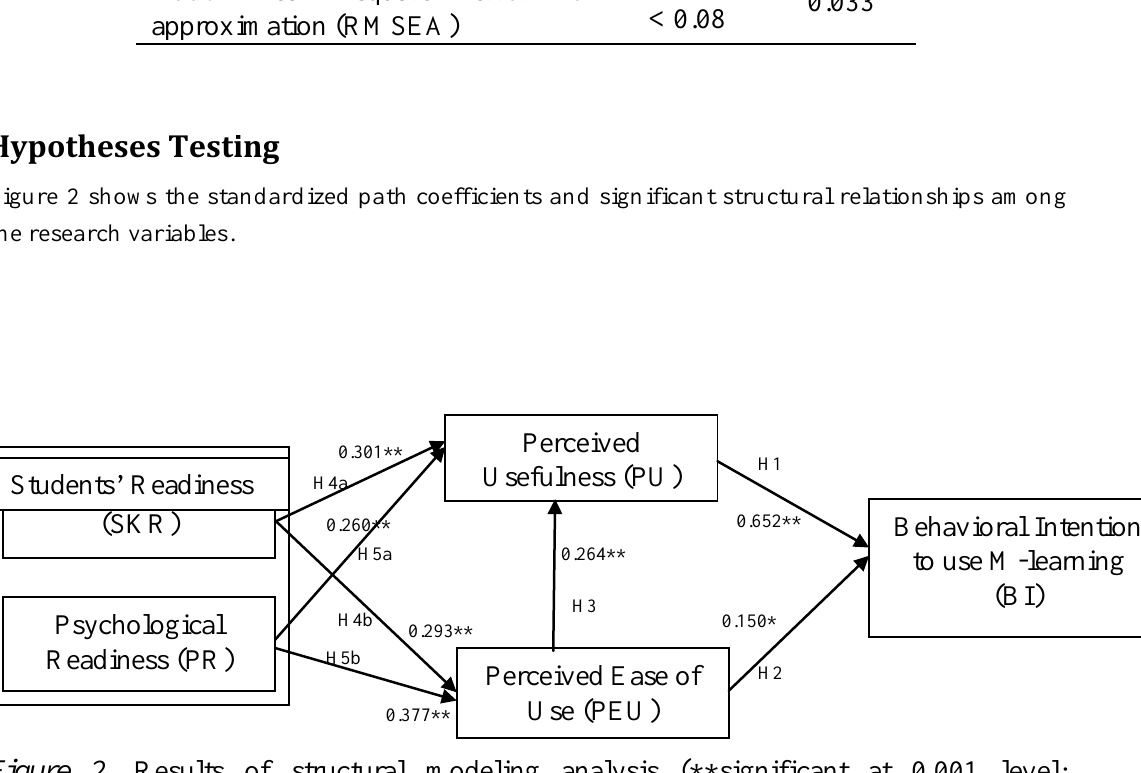
Figure 2. Results of structural modeling analysis (**significant at 0.001 level; *significant at .05 level)